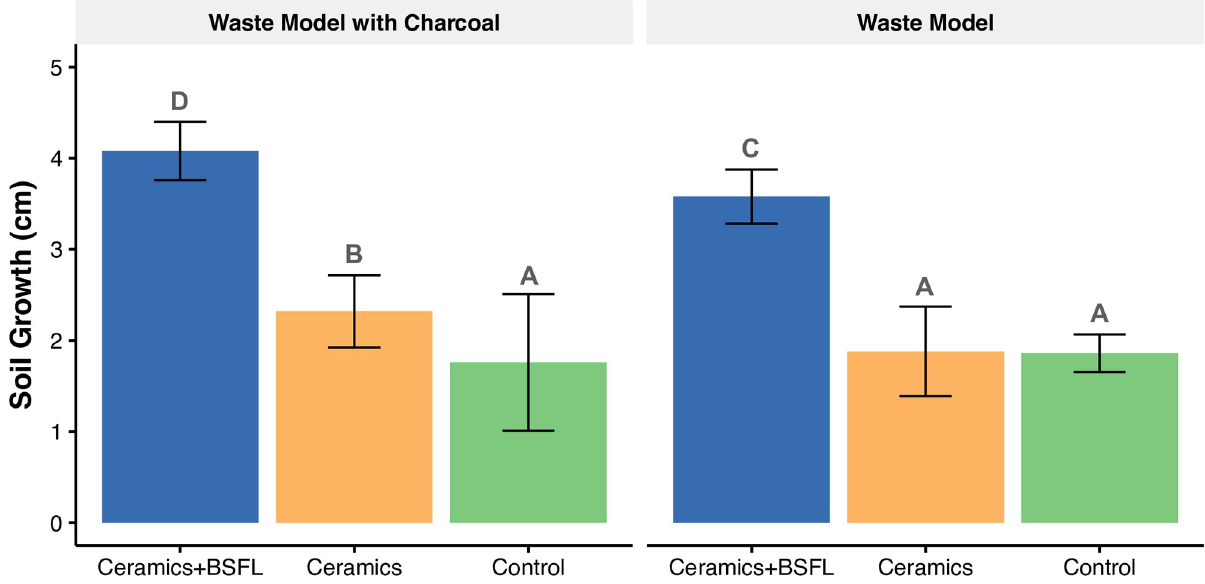
Fig 2. Black soldier fly larvae (BSFL) increase soil growth in comparison to treatments without larvae. Larvae fed with the Waste Model with charcoal (WMC) presented the highest soil growth among all the treatments and waste model types. Treatments with ceramics in the absence of larvae and absolute controls showed no significant differences. Five replicates per treatment. The error bars represent the 95% confidence intervals (CI) of independent group t-tests. Treatments sharing a letter are not significantly different at the 5% level.